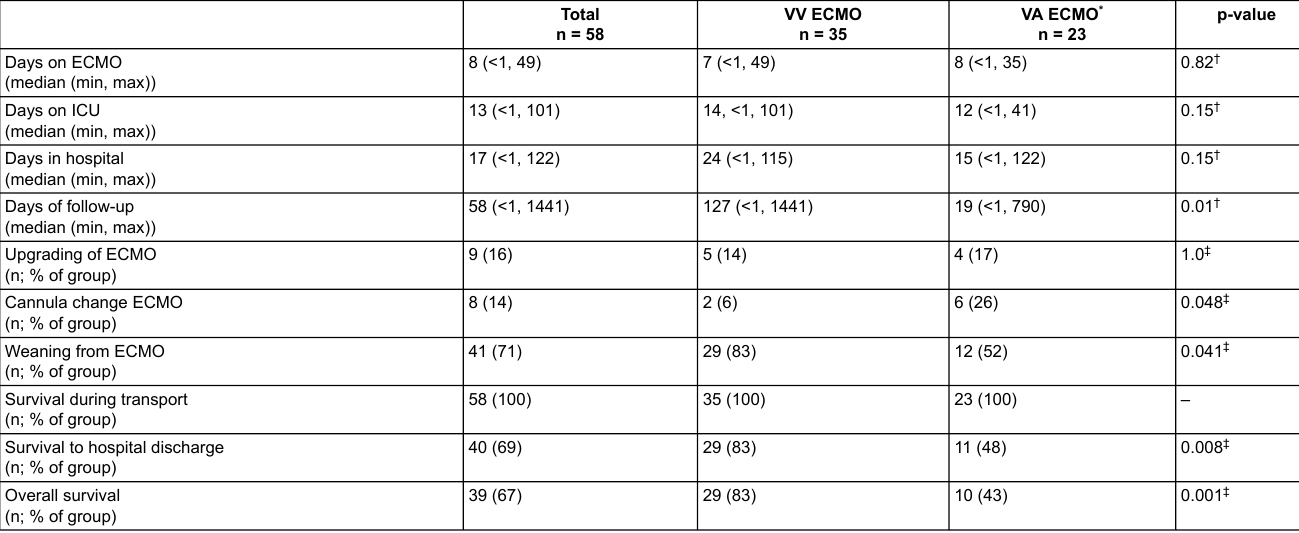
Table 4A: Follow-up data by type of extracorporeal membrane oxygenation (ECMO).